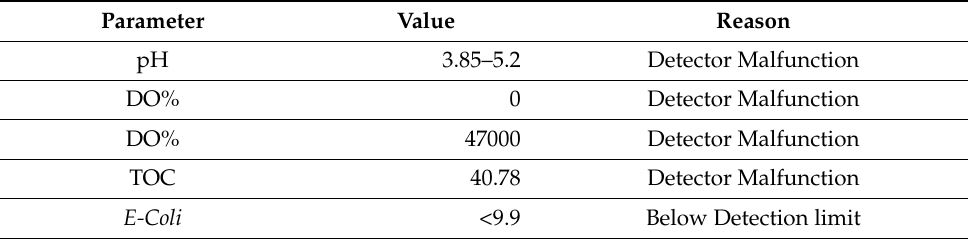
Table A2. Quality control parameters.